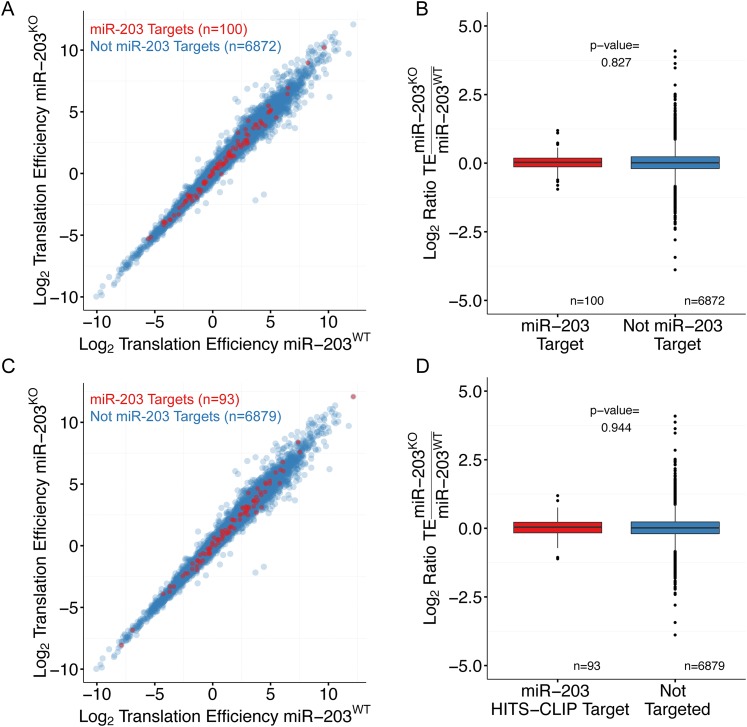
miR-203 targets do not display translation efficiency changes upon miR-203 ablation.(A) Comparison of translation efficiency for miR-203 targets (red) and non-targeted transcripts (blue) identified by expression meta-analysis. (B) Quantification of the change in translation efficiency in miR-203 KO samples for miR-203 targets identified by expression meta-analysis. (C) Comparison of translation efficiency for miR-203 targets identified by Ago2-HITS-CLIP (red) and non-targeted transcripts (blue). (D) Quantification of the change in translation efficiency in miR-203 KO samples for miR-203 targets based on Ago2-HITS-CLIP.